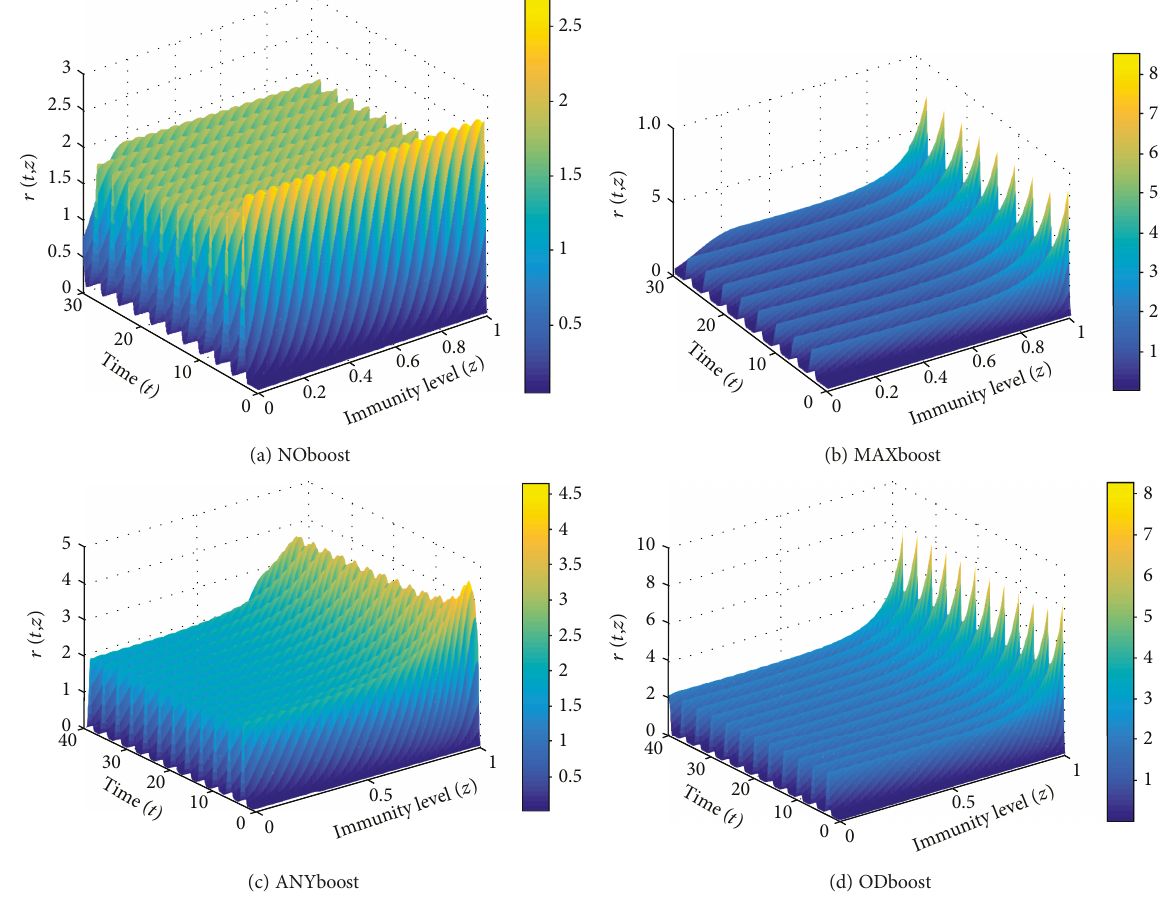
Figure 8: The r t , z solution for di ff erent boosting mechanisms. (a) Waning immunity, absence of immune boosts. (b) Boost to maximal level of immunity. (c) Uniform probability of boosting to any higher immunity level. (d) Nonlinear boost according to Figure